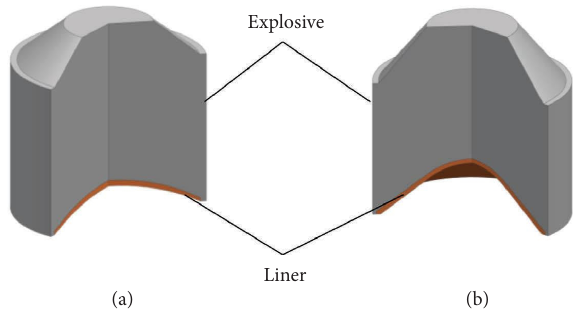
Figure 2: Structure of the shaped charge. (a) EFP. (b)